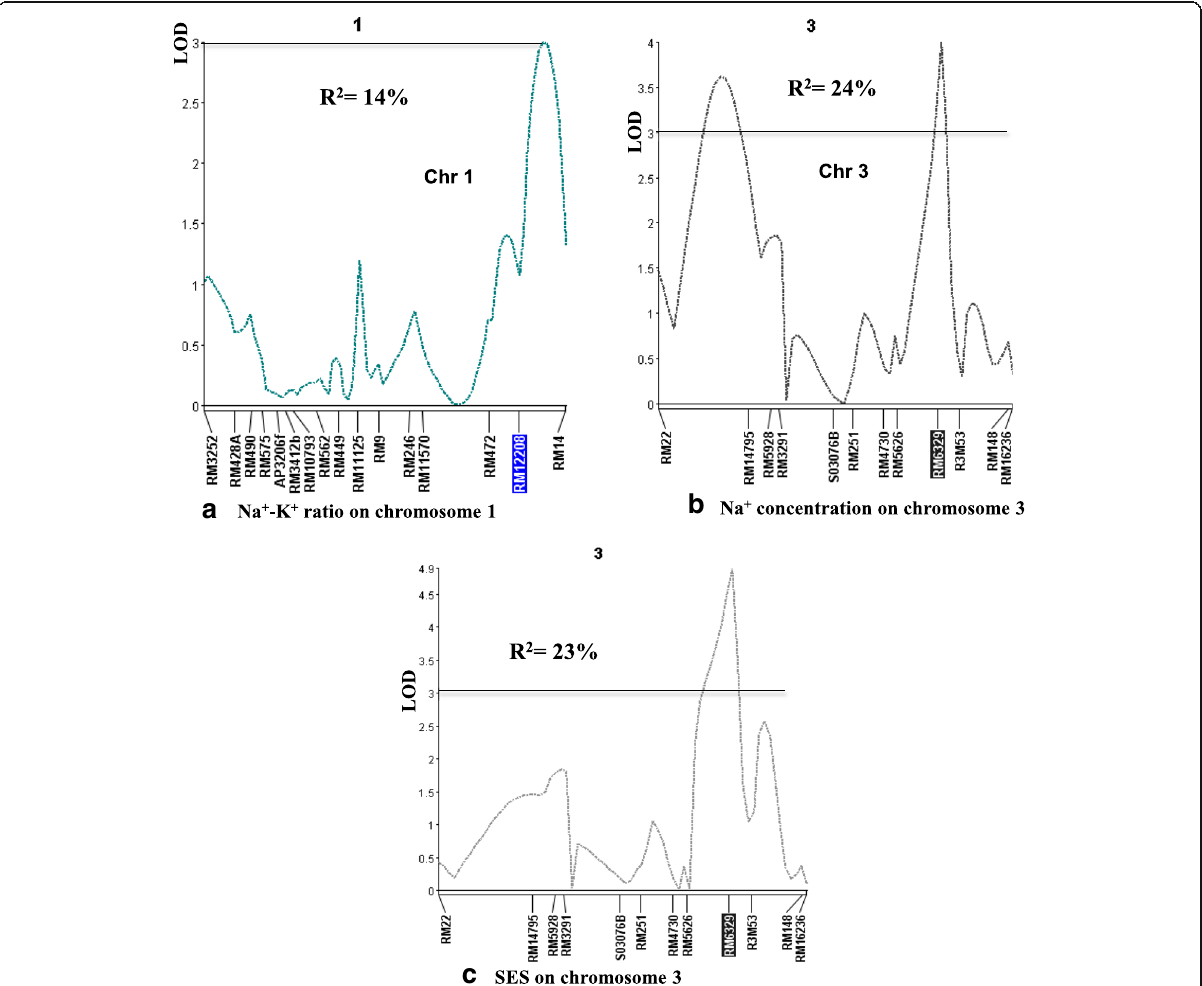
Fig. 3 QTL likelihood curves of the LOD score of a Na + -K + ratio on chromosome 1, b Na + concentration and c overall phenotypic performance (SES) on chromosome 3, that were above the significance threshold of LOD = 3.0 and explained approximately 14%, 24% and 23% of the phenotypic variance for each